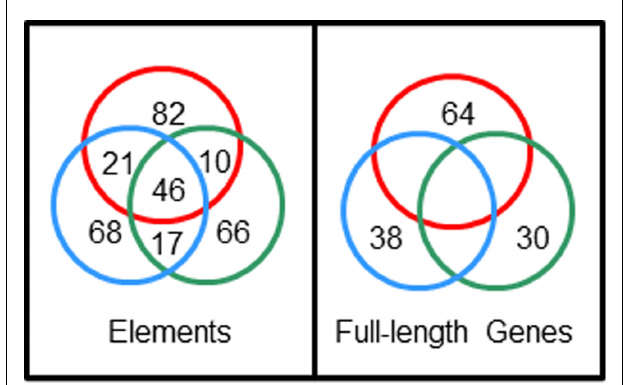
FIGURE 7 | Sp185/333 gene sequences are not shared among sea urchins but element sequences are shared among genes. Full-length genes were cloned and sequenced from three sea urchins; 38 unique genes from animal 10 (blue circle), 64 unique genes from animal 2 (red circle), 30 unique genes from animal 4 (green circle). Nucleotide sequences were compared among full-length genes and among individual elements, and the numbers of shared unique sequences are shown in the intersections of the circles. Unpublished figure provided by Katherine